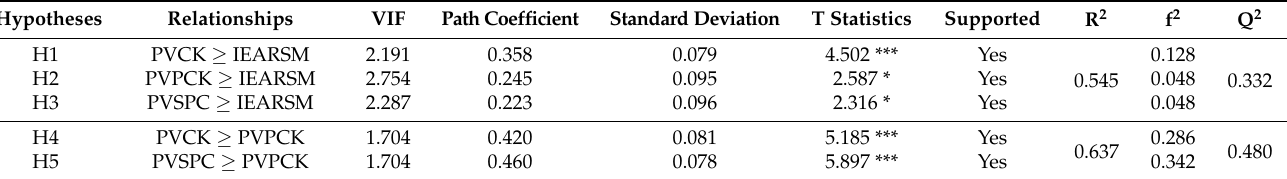
Table 5. The results for the structural model.